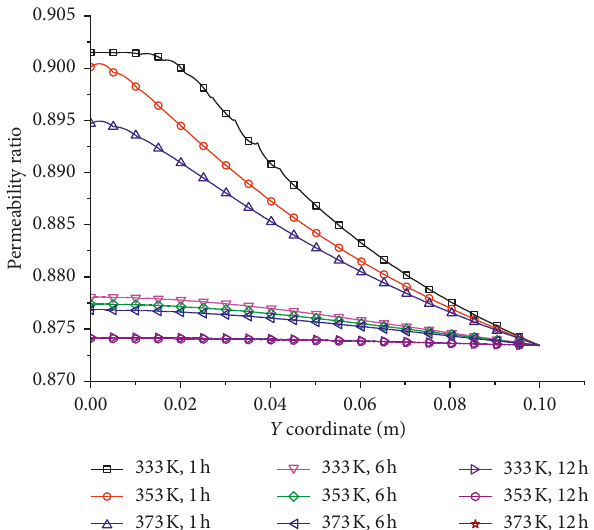
Figure 12: Permeability distribution with different temperatures.